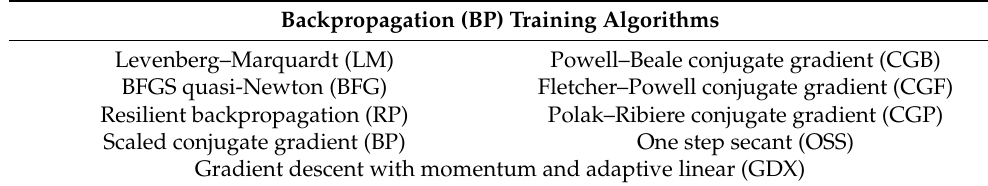
Table 3. Backpropagation training algorithms of the developed